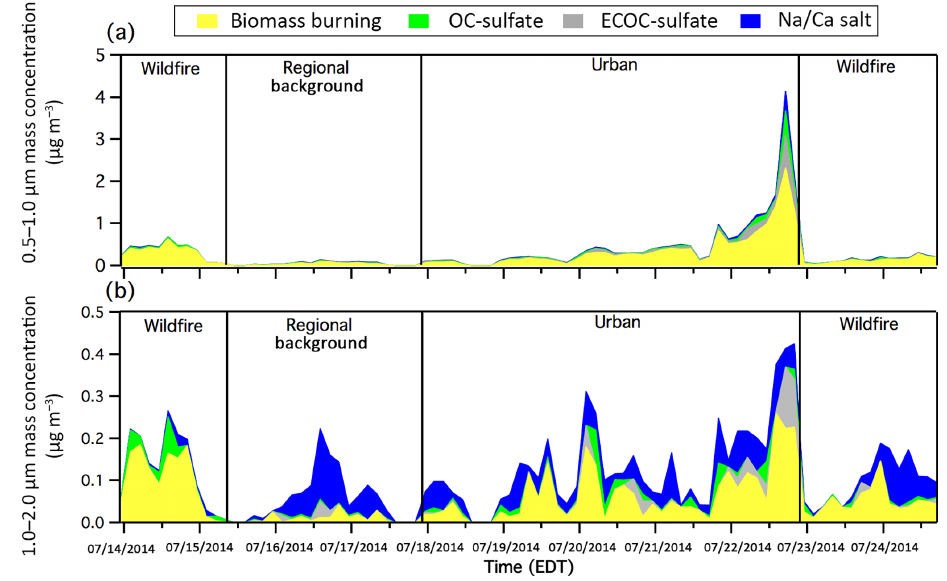
Figure 5. The 3h binned mass concentrations of (a) 0.5–1.0µm and (b) 1.0–2.0µm particle types, as measured with the ATOFMS. Gaps in the data correspond to periods when APS data were not available for scaling.